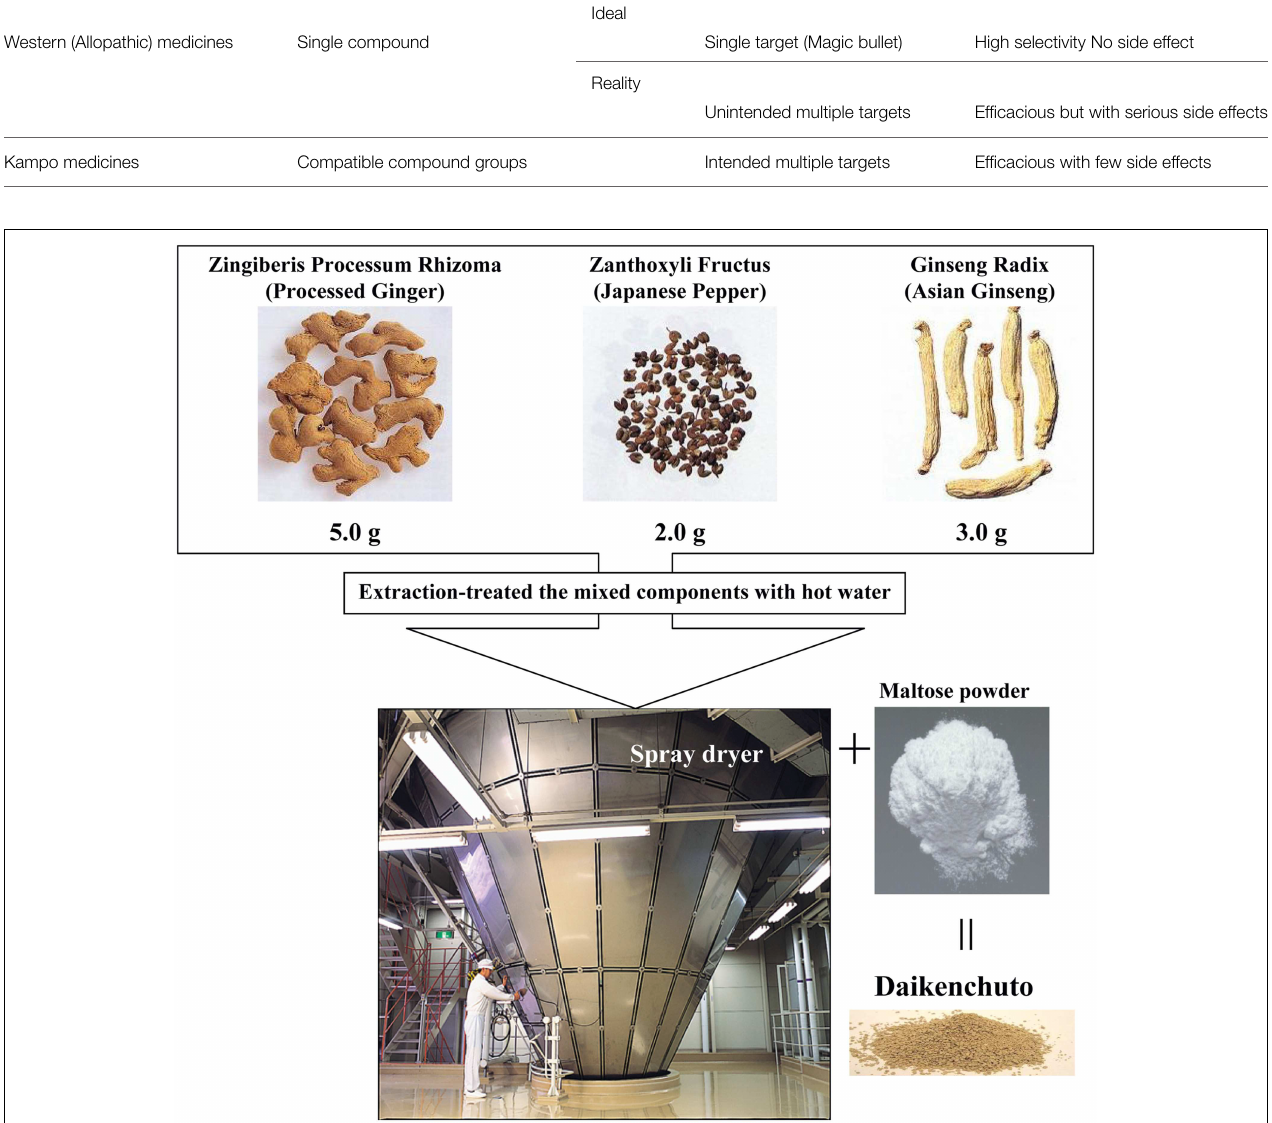
TABLE 1 | Differences between Western and Kampo medicines.